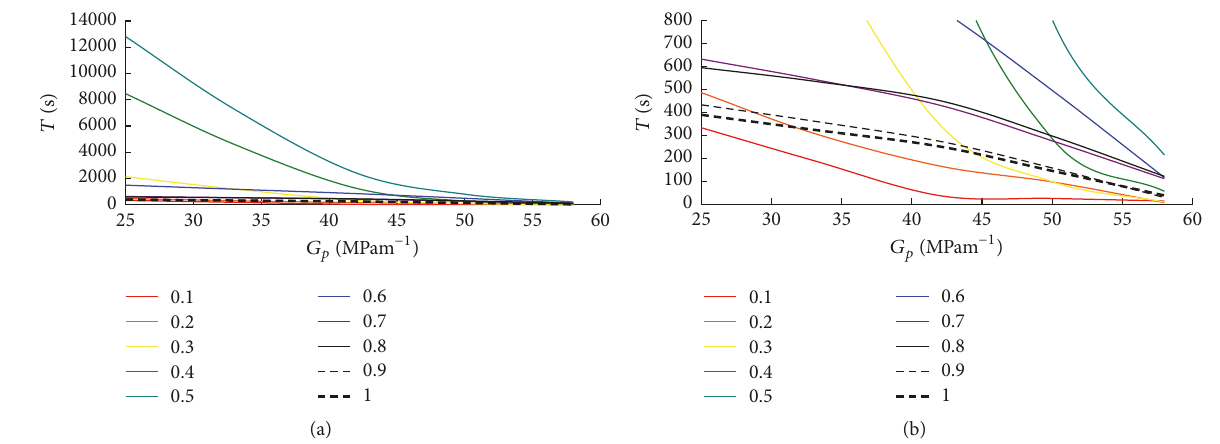
Figure 4: Variation of seepage instable duration with pressure gradient.